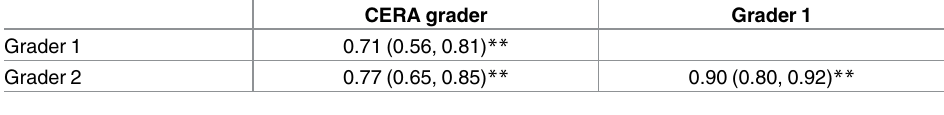
Table 8. Intra-class correlation coefficient (95% CI) among CERA grader and local graders in grading DR after learning from a test set of 32 eyesgraded by the CERA grader.